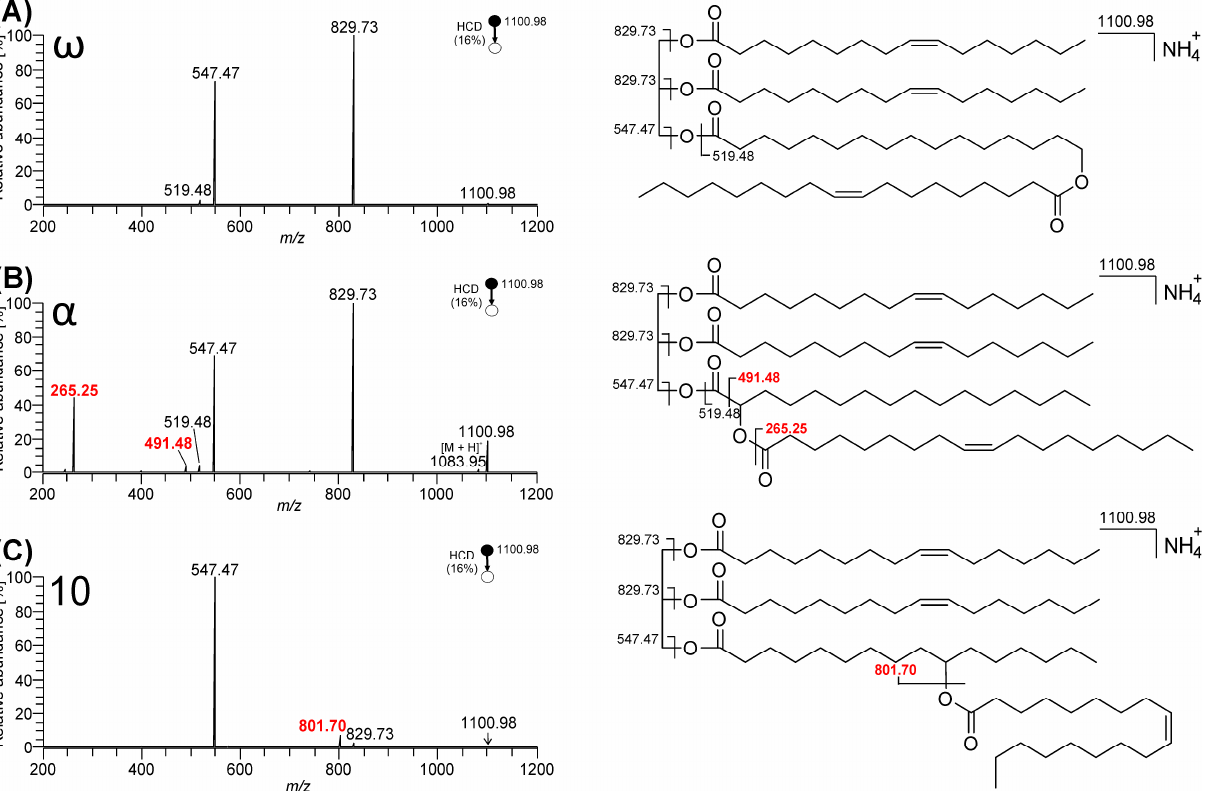
Figure 2. MS 2 HCD spectra of TG ‐ EST [M + NH 4 ] + (NCE 16%): ( A ) TG ‐ EST 1 — ω‐ isomer; ( B ) TG ‐ EST 2 — α‐ isomer; ( C ) TG ‐ EST 3 —10 ‐ isomer. Diagnostic fragment ions for the various positional isomers are highlighted in red.